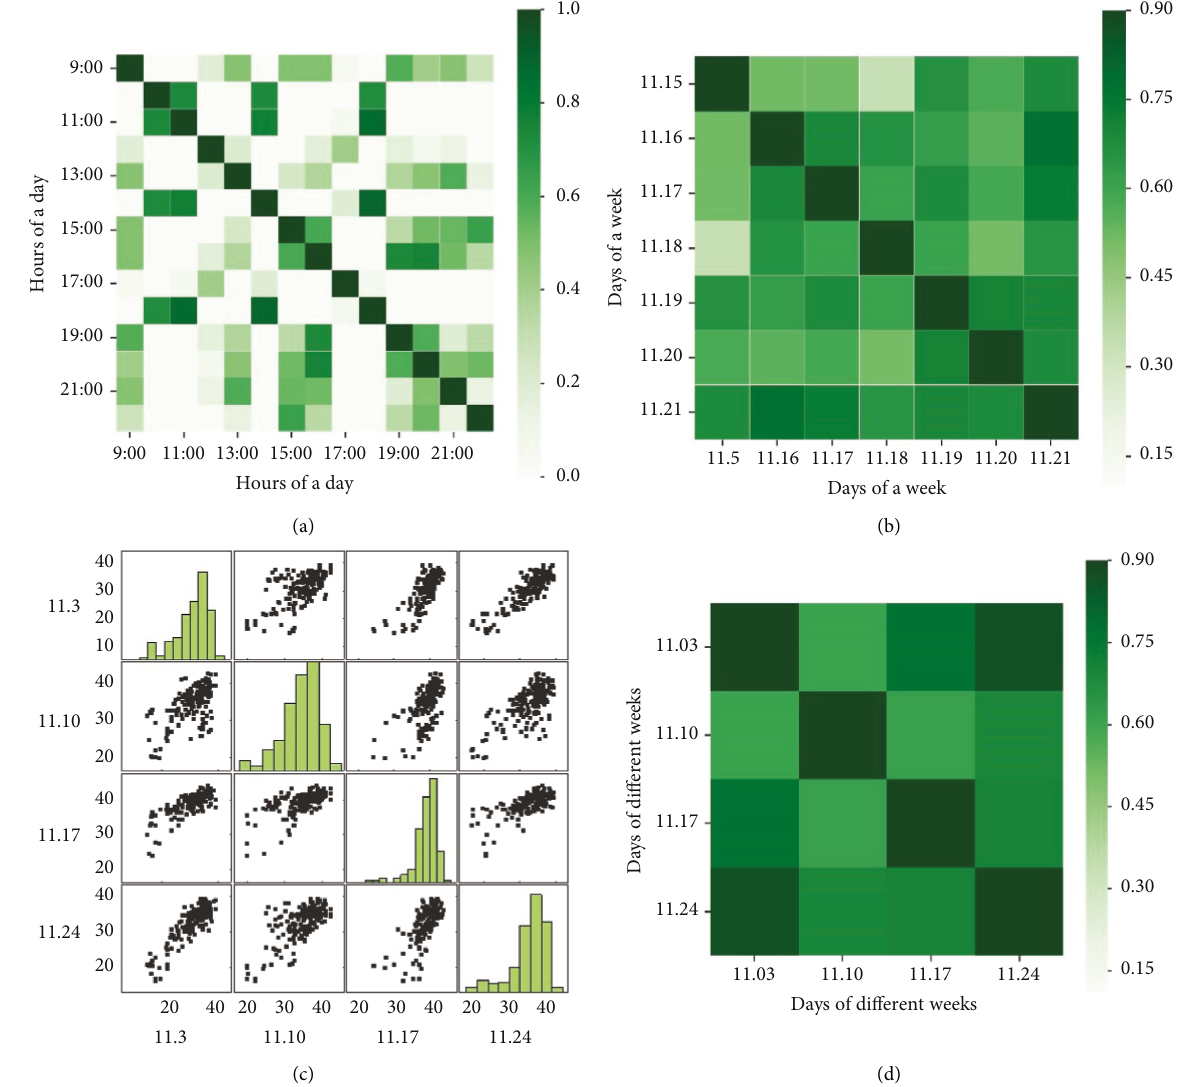
Figure 9: Temporal dependency analysis of the urban roads. (a) Correlation coefficient matrix of traffic state of different hours in a day; (b) correlation coefficient matrix of traffic state of different days in weeks; (c) speed scatter diagram of the Thursdays in different weeks; (d) correlation coefficient matrix of the Thursdays in different